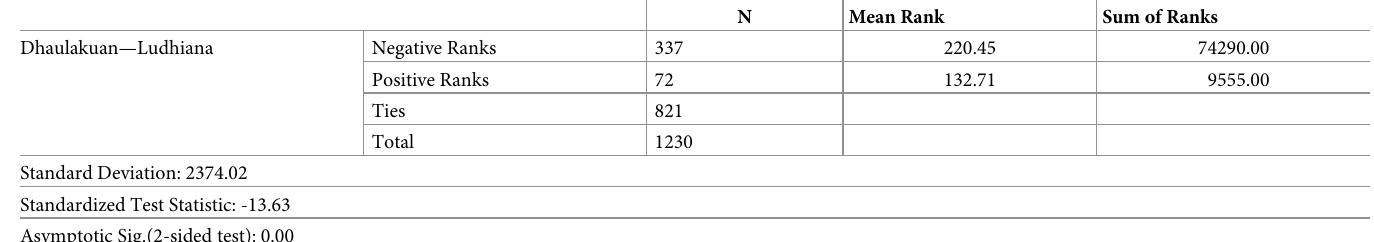
Table 3. Summary table of Wilcoxon Signed Rank test on paired set of accessions for Dhaulakuan and Ludhiana disease screening